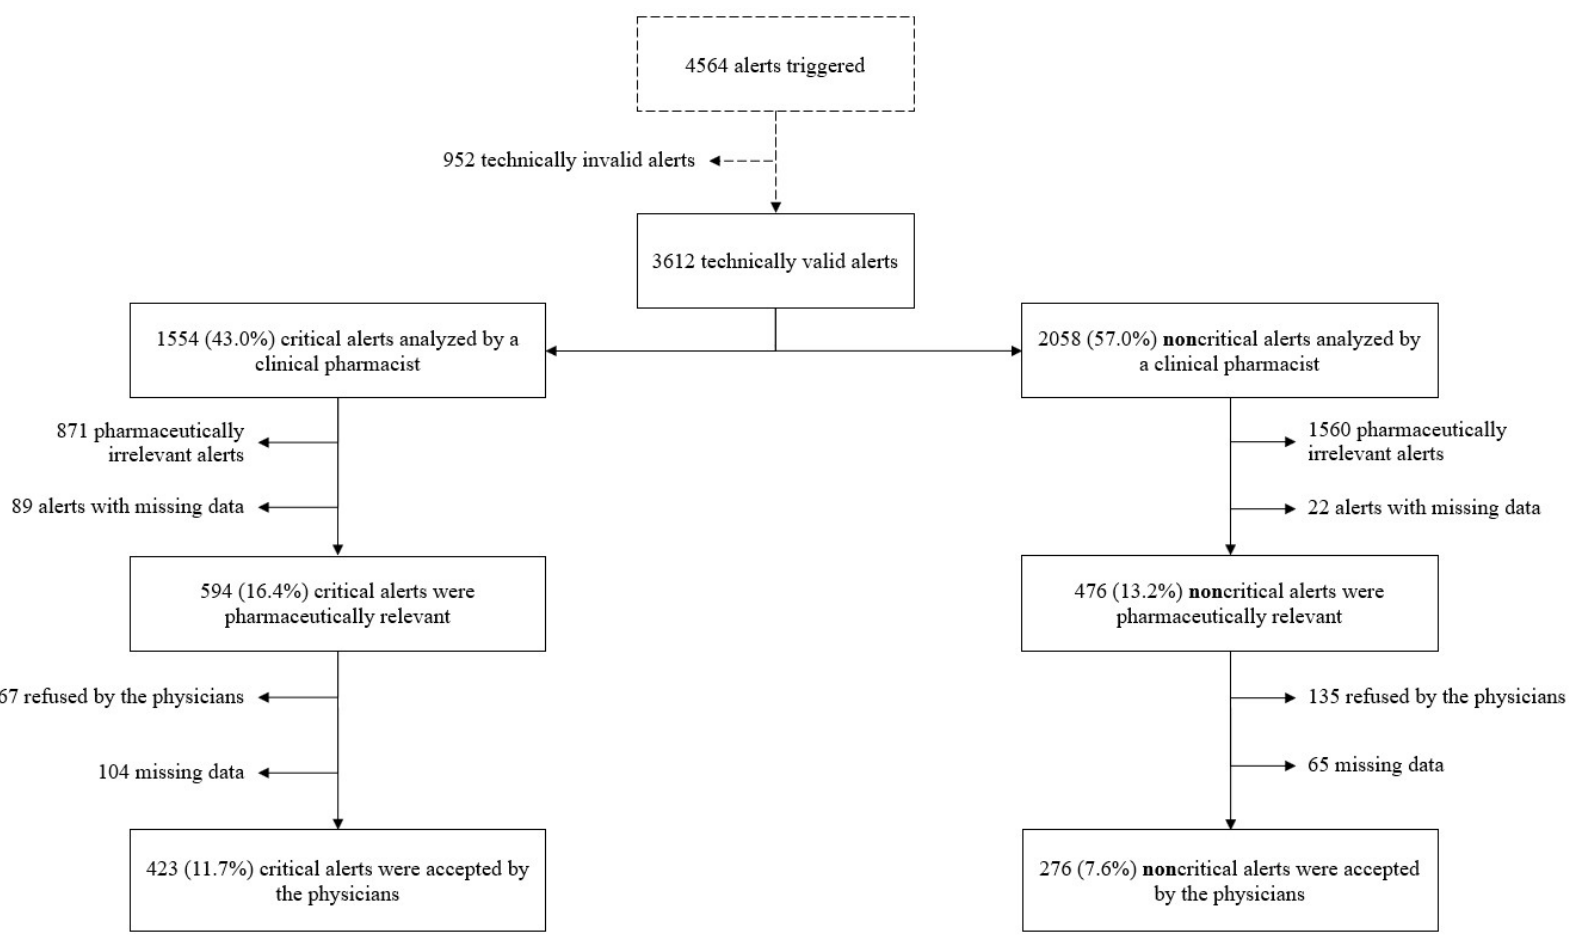
Figure 2. Flow chart of the analysis of critical and noncritical alerts triggered by the CDSS during the 22-month study (the data are reported as proportions of the 3612 technically valid alerts).